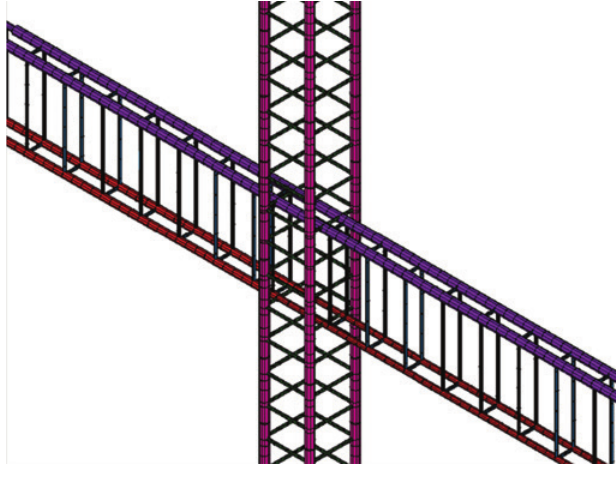
Figura 6 Posicionamento do reforço com PRFC – vista superior